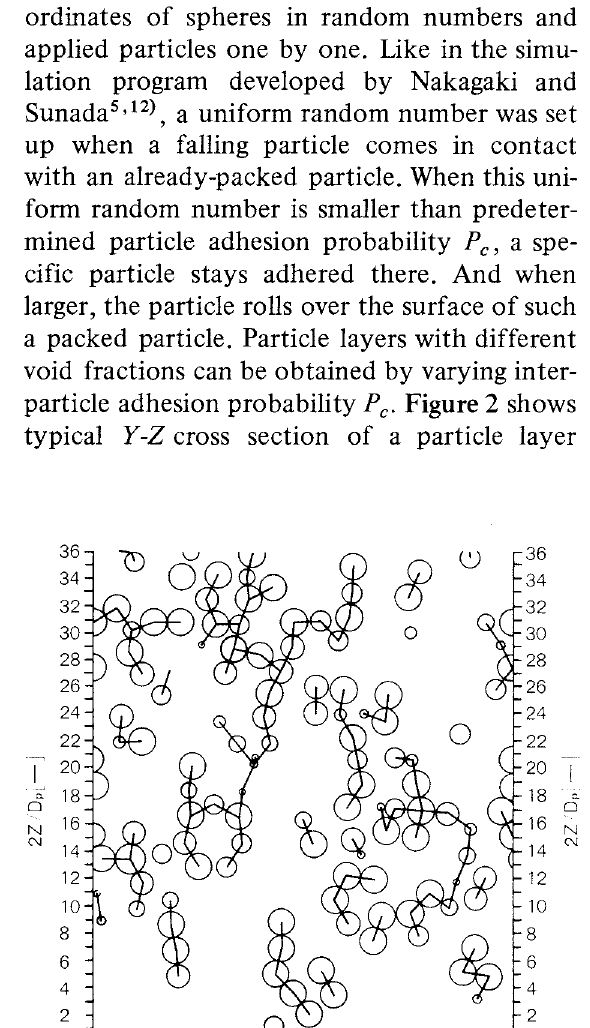
Fig. 1 Cross section of particle system by computer simulation program